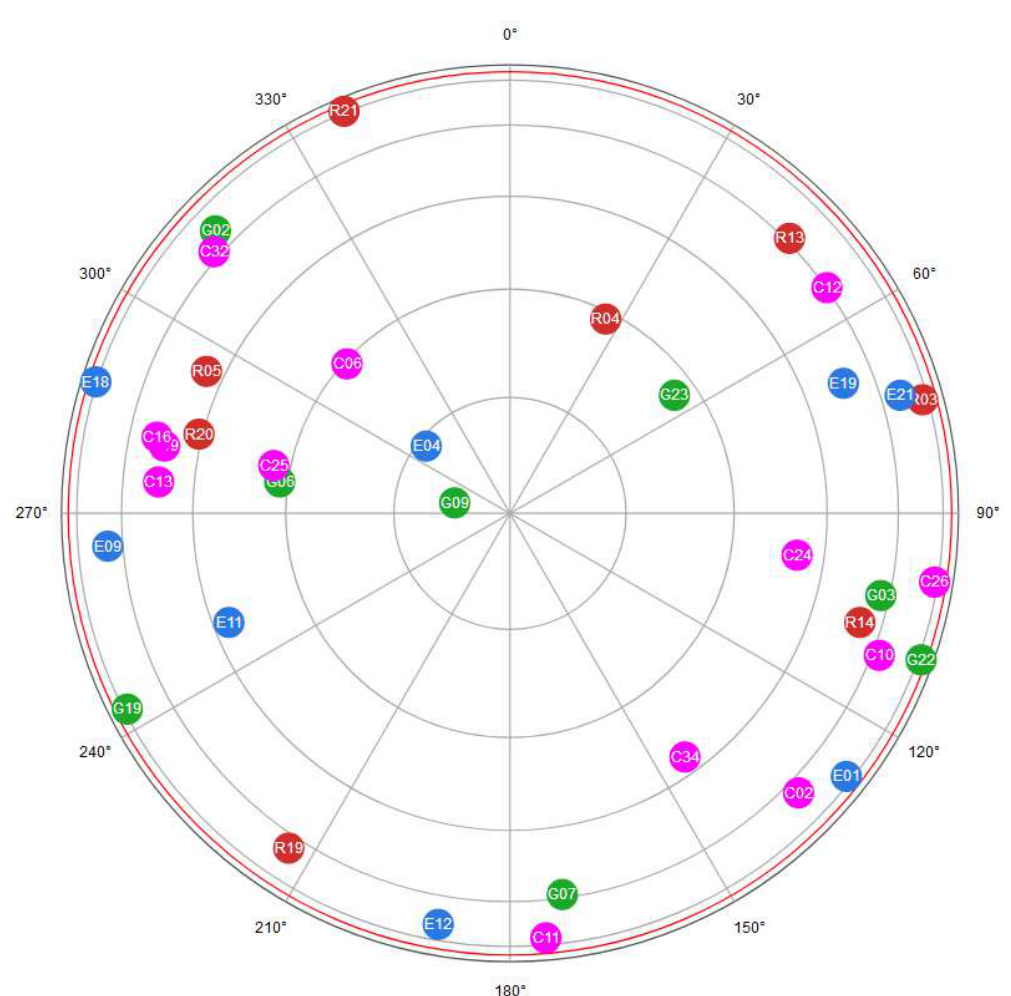
Figure 2. Skyplot of visible satellites in one of the selected epochs of measurements: green, red, blue and purple circles represent the GPS, GLONASS, Galileo, and BeiDou satellites, respectively .